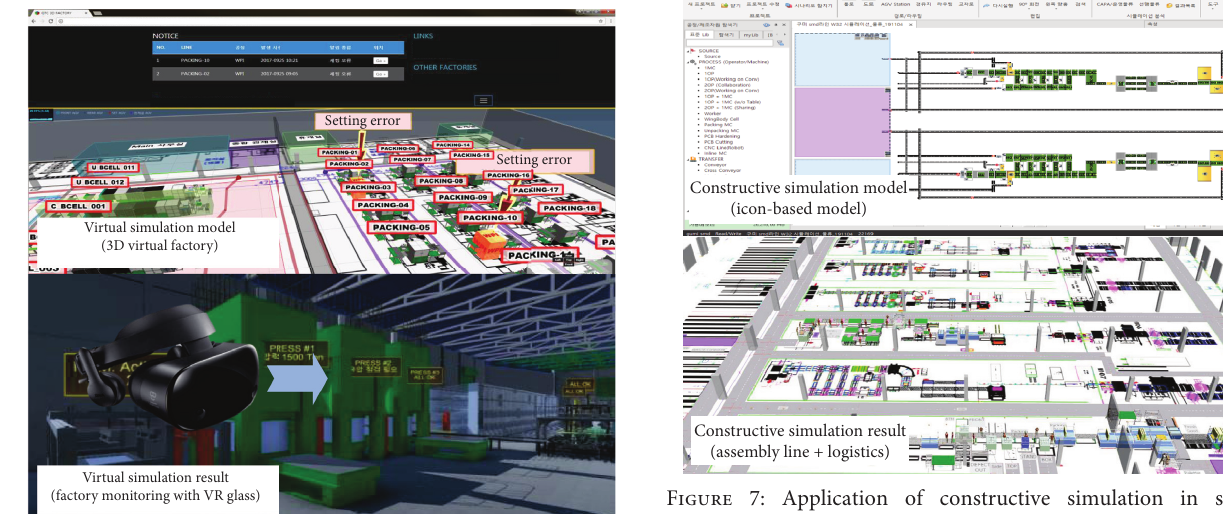
Figure 6. Created as a discrete event simulation model, it can be simulated using a discrete event simulation engine.